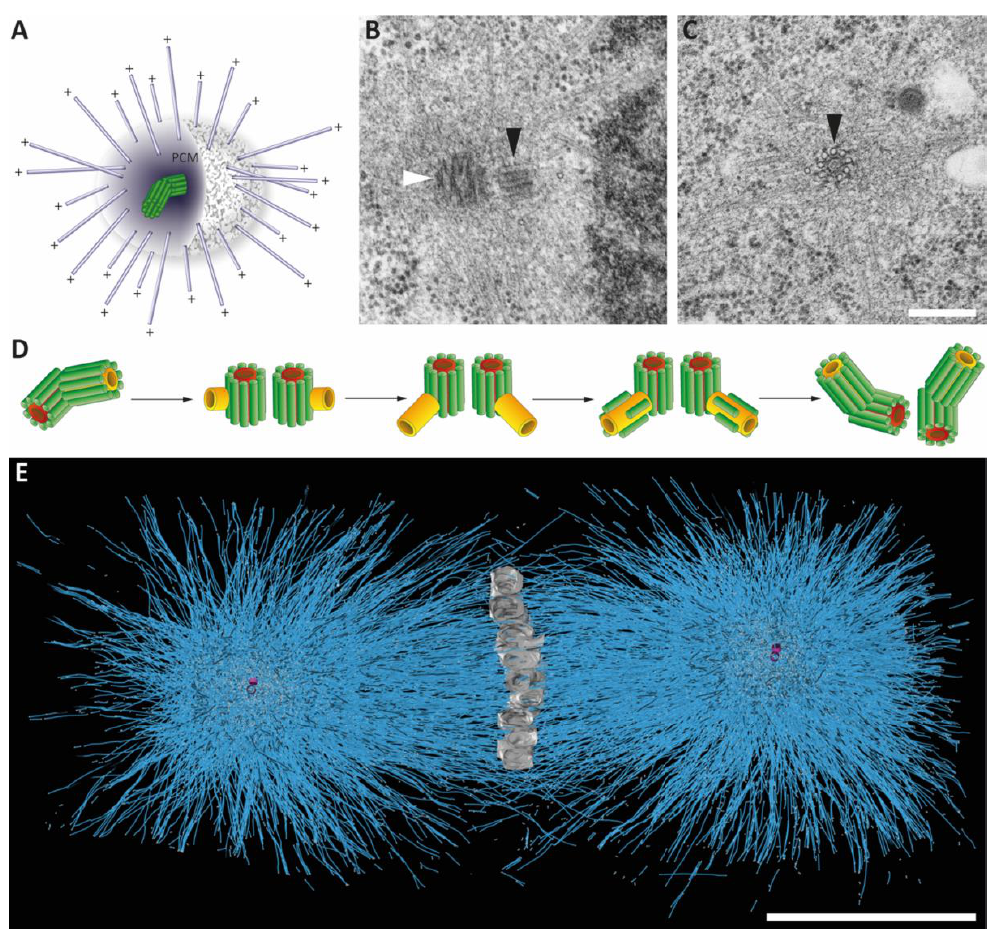
Figure 5. Centrosomes in the early Caenorhabditis elegans embryo. ( A ) Schematic representation of the centrosome with a pair of centrioles (green) within the pericentriolar material (PCM) and the nucleated microtubules (blue). The minus ends are anchored in the PCM, the plus ends (+) are growing out to cellular target sites. ( B , C ) Electron micrographs of C. elegans centrioles with surrounding PCM as observed in a 64-cell embryo. The mother (white arrowhead) and the daughter centriole (black arrowhead) are marked ( B ). C. elegans centriole in cross-section displaying a central tube (note the appearance of an inner tube within the central tube) and a peripheral arrangement of nine singlet microtubules (black arrowhead in C ). Along the side of the microtubules, paddlewheel-like structures are twisted in a clockwise direction (black arrowhead). Modified from [31]. Scale bar, 250 nm. ( D ) Schematic drawing illustrating centriole duplication in C. elegans . Mother centrioles are shown with a red central tube, daughter centrioles with a yellow tube and centriolar microtubules in green. Centrosome duplication starts with a splitting of the centriole pair. New central tubes are formed perpendicular to the sperm-derived centrioles. The central tubes of the newly formed daughter centrioles elongate and new centriolar microtubules are assembled around the central tube. This results in two centrosomes each composed of one mother and one daughter centriole. Modified from [14]. ( E ) Full reconstruction of the first mitotic spindle in the one-cell C. elegans embryo. Chromosomes (grey) are arranged at the metaphase plate. The reconstruction shows the numerous microtubules (blue lines) of the first mitotic spindle. The centrioles are shown in magenta. Adapted from [32]. Scale bar, 5 µm.